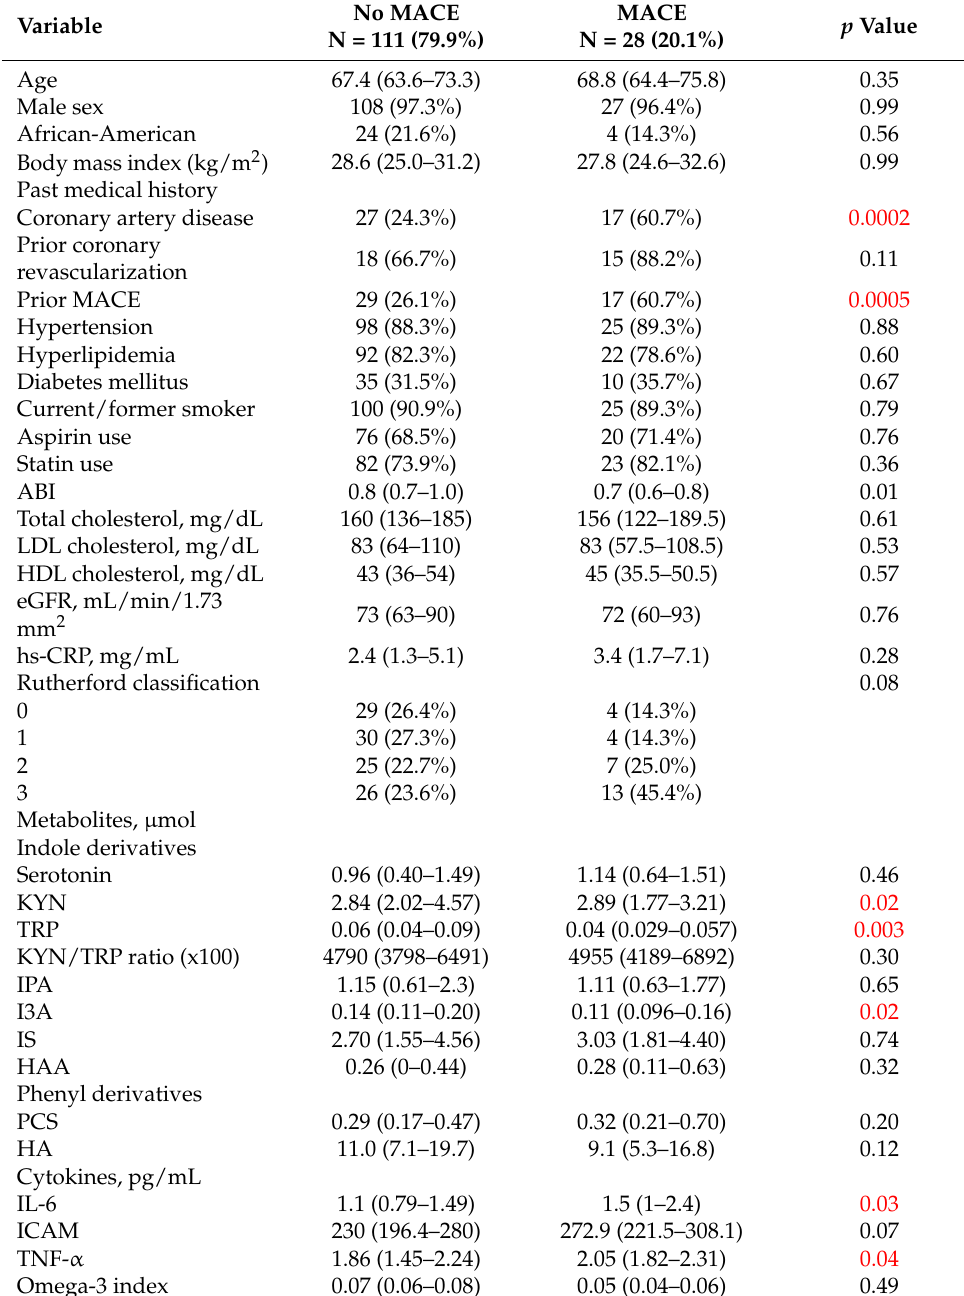
Table 3. Univariate associations with MACE during the follow-up